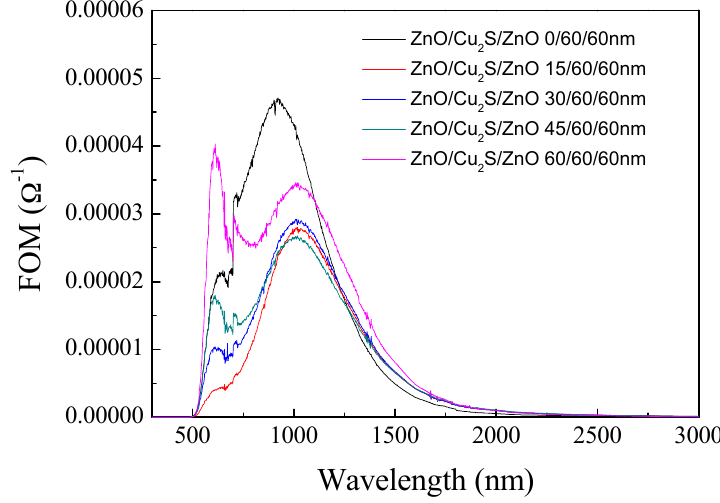
Figure 26. The figure of merit of ZnO/Cu 2 S/ZnO/glass complex films for different thickness.